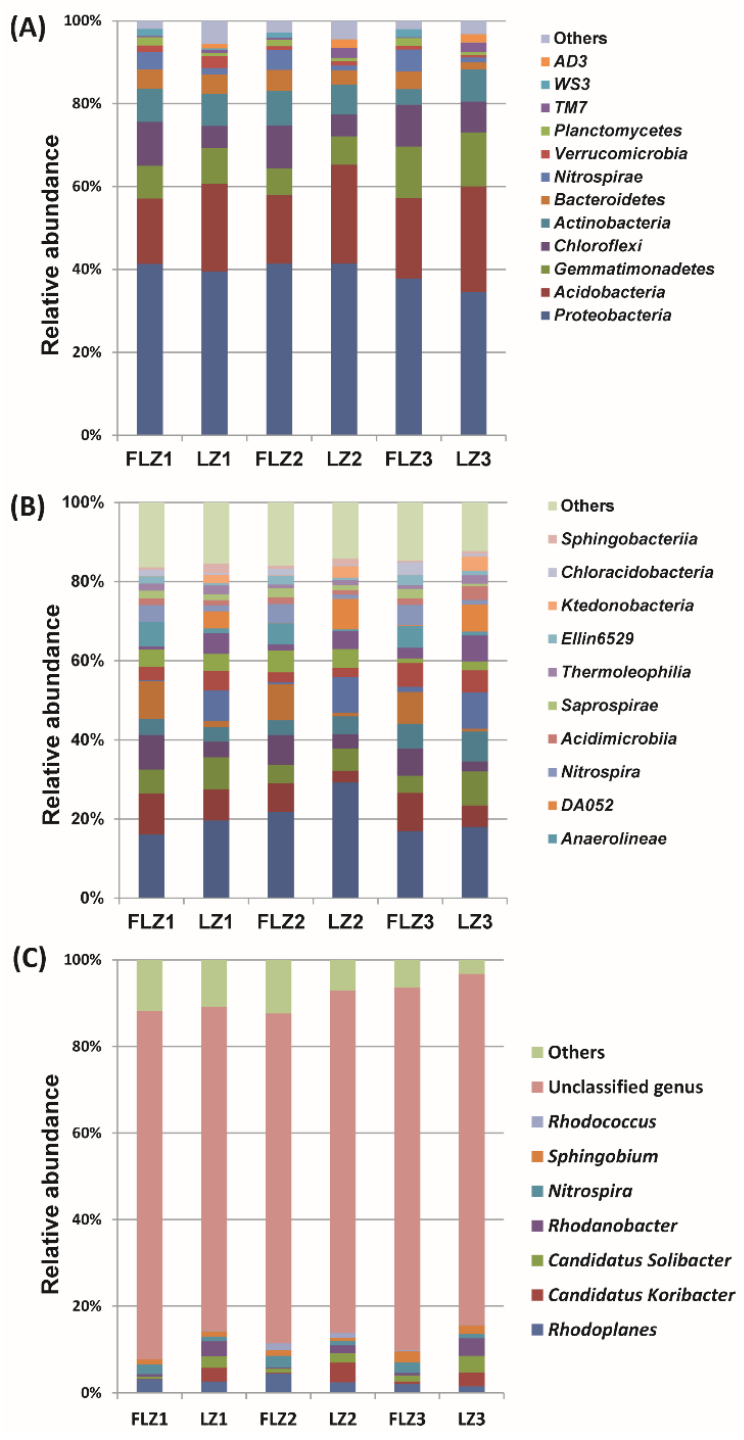
Figure 5. Bacterial community structures at ( A ) phylum, ( B ) class and ( C ) genus level at the six different soil sites. The relative abundance was defined as the percentage of the in total effective bacterial sequences in sample, classified using SILVA databank. Phyla, classes and genera making up less than 1% of total composition in both the libraries were classified as ‘other’. LZ1, FLZ, LZ2, FLZ2, LZ3 and FLZ3 represent the soil samples collected from continuous cropping (LZ) and main cropping (FLZ) at the 4 May (LZ1 and FLZ1), 14 July (LZ2 and FLZ2) and 19 September (LZ3 and FLZ3), 2016.